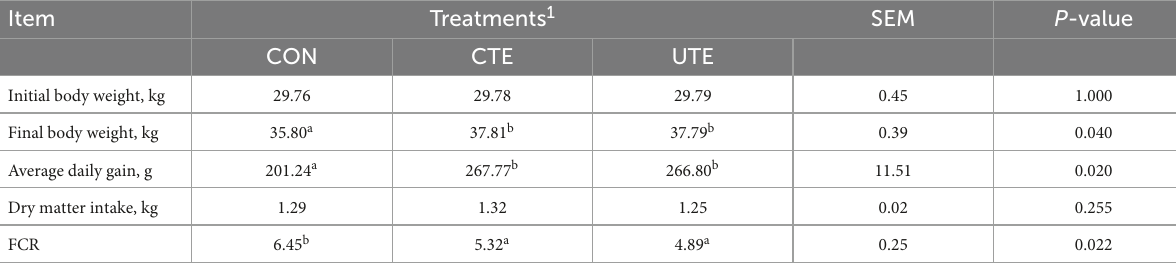
TABLE 3 Effects of coated and uncoated trace elements on growth performance of sheep.